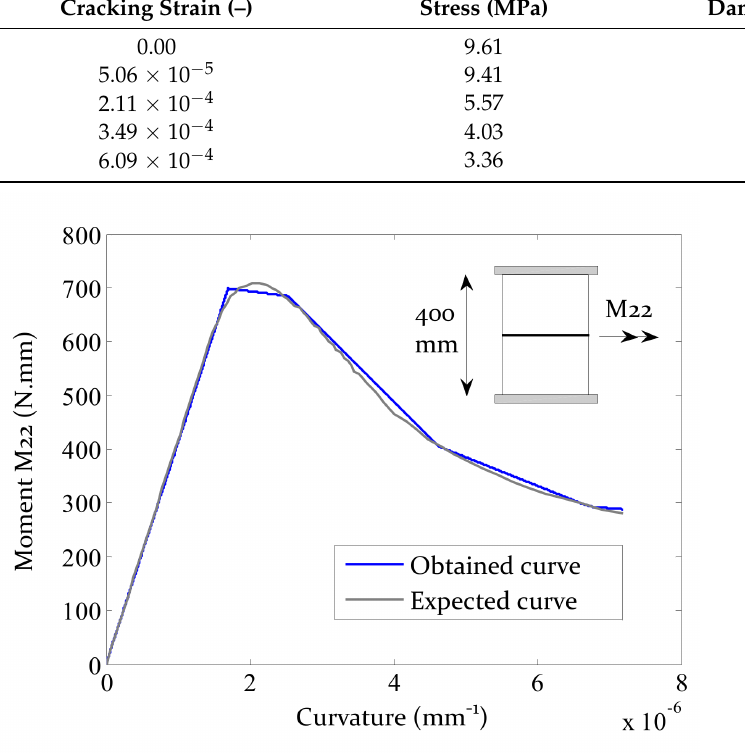
Figure 9. Quasi–static test: expected vs. obtained bending moment capacity